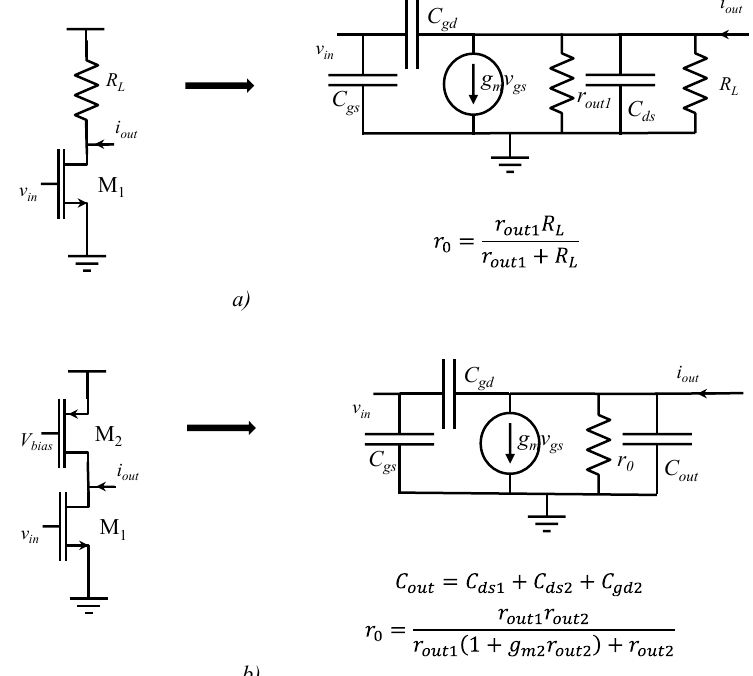
Fig. B.1. Single Input Single Output (SISO) con fi gurations of